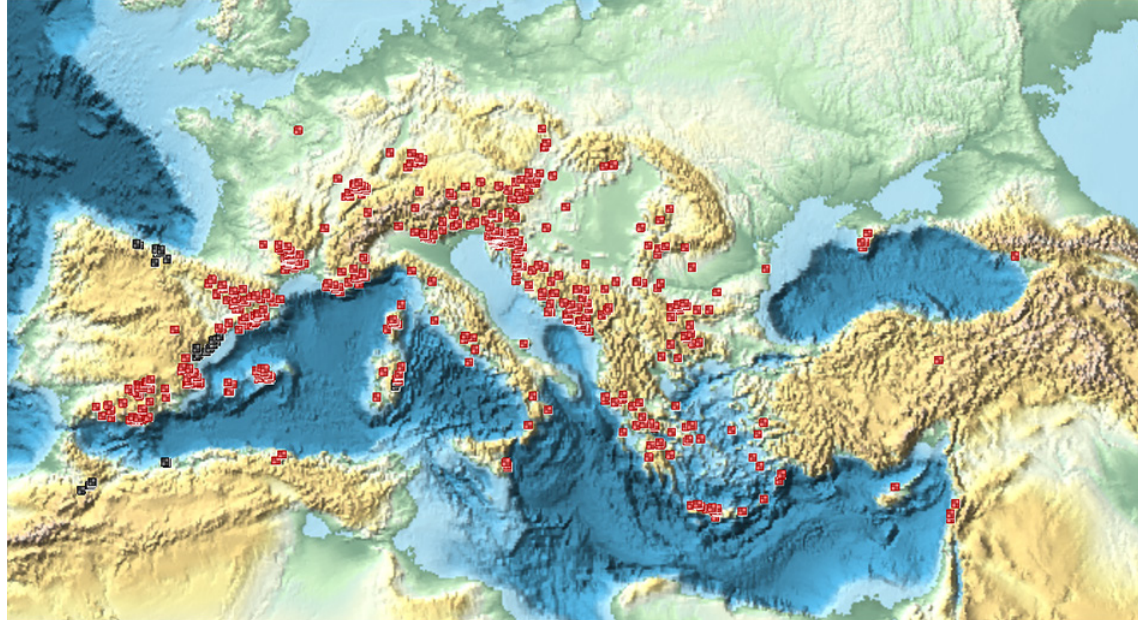
Fig. 209. Distribution map of Plusiocampinae Paclt, 1957 (red squares) and the tachycampoid phyletic group species (black squares) in the Euro-Mediterranean